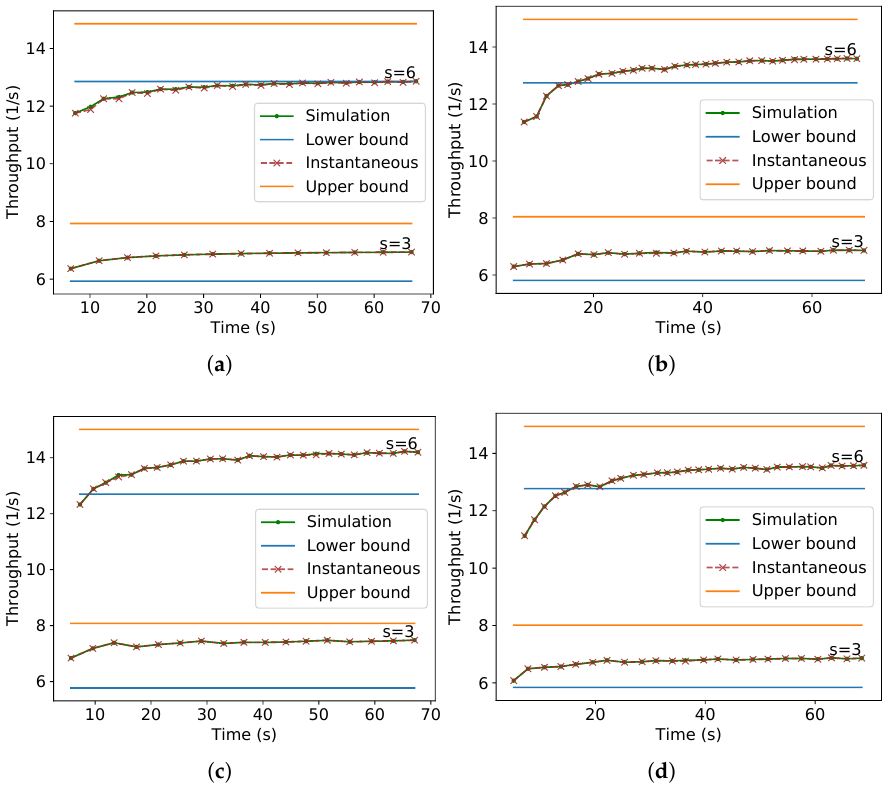
Figure 34. Comparison of simulation data with the asymptotic and instantaneous throughput for hexagonal packing with different values of s and θ . ( a ) θ = 0; ( b ) θ = π / 12; ( c ) θ = π / 6; ( d ) θ = 5 π /